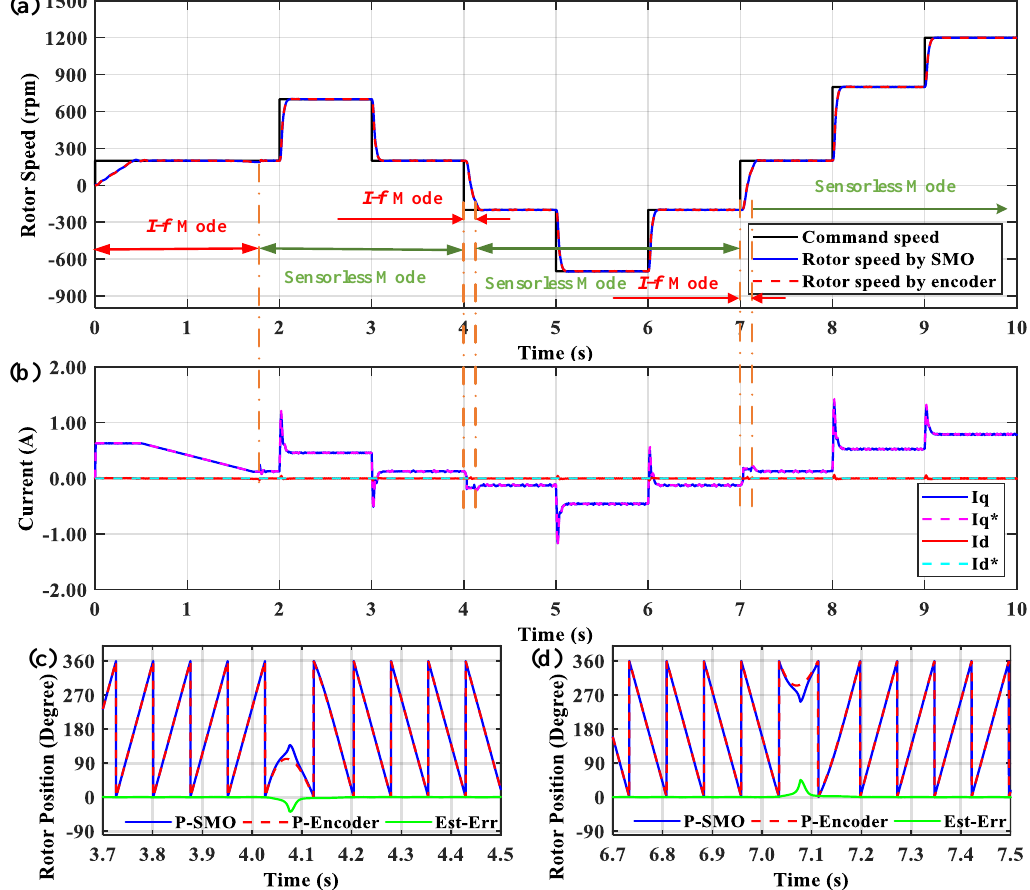
Figure 10. Simulation results in the case of the varied rotational direction for: ( a ) speed response; ( b ) current response; ( c ) rotor position (positive–negative); and ( d ) rotor position (negative–positive).